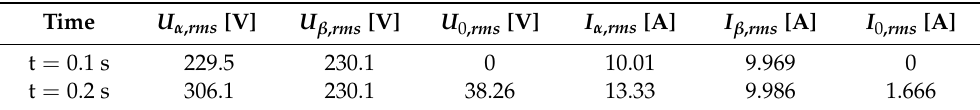
Table 41. Simulation results before and after the change (at steady states). Simulation Results Using Matlab/Simulink, Simulation Step 200 µ s Measurable quantities, i.e., voltages and currents in α , β ( rms ) , and their parameters are given in Table 41.